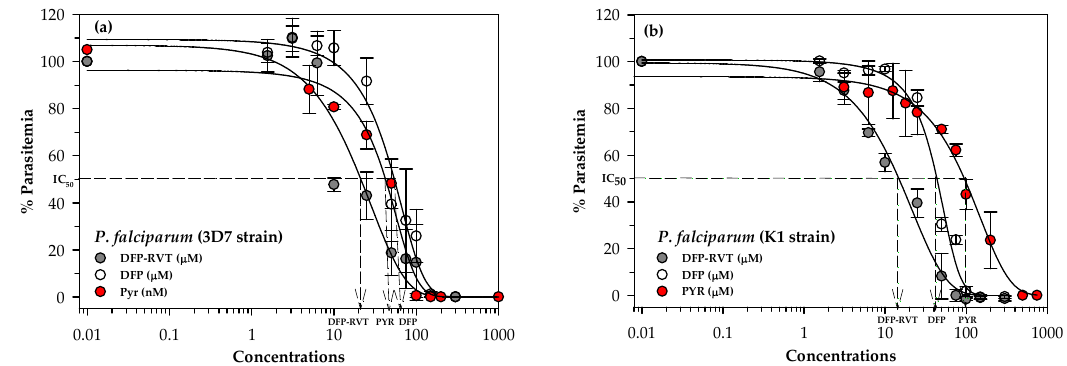
Figure 4. Inhibitory effects of DFP-RVT, DFP and PYR monotherapy on the growth of the P. falciparum 3D7 strain ( a ) and the K1 strain ( b ). Data obtained from three independent triplicate experiments are expressed as mean±SD values. Table 2. Absolute IC 50 values of DFP-RVT, DFP and PYR for inhibition of P. falciparum growth.